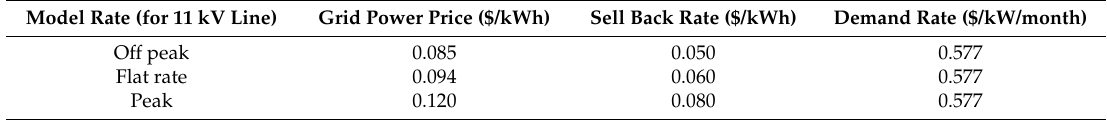
Table 2. Scheduled rate of National Grid Electricity in Bangladesh [23].